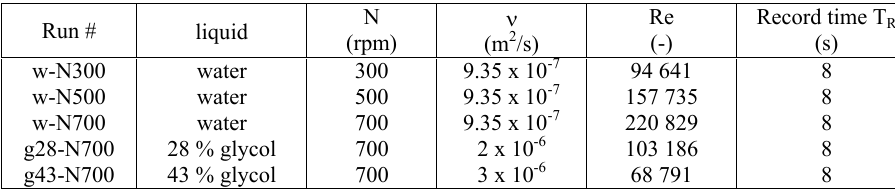
Table 1. Operational parameters.